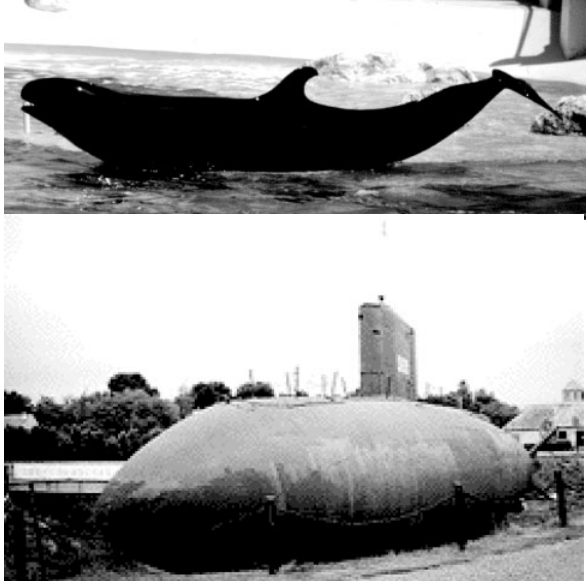
Figure 1 Fusiform shapes of dolphin (above) and submarine, USS Albacore